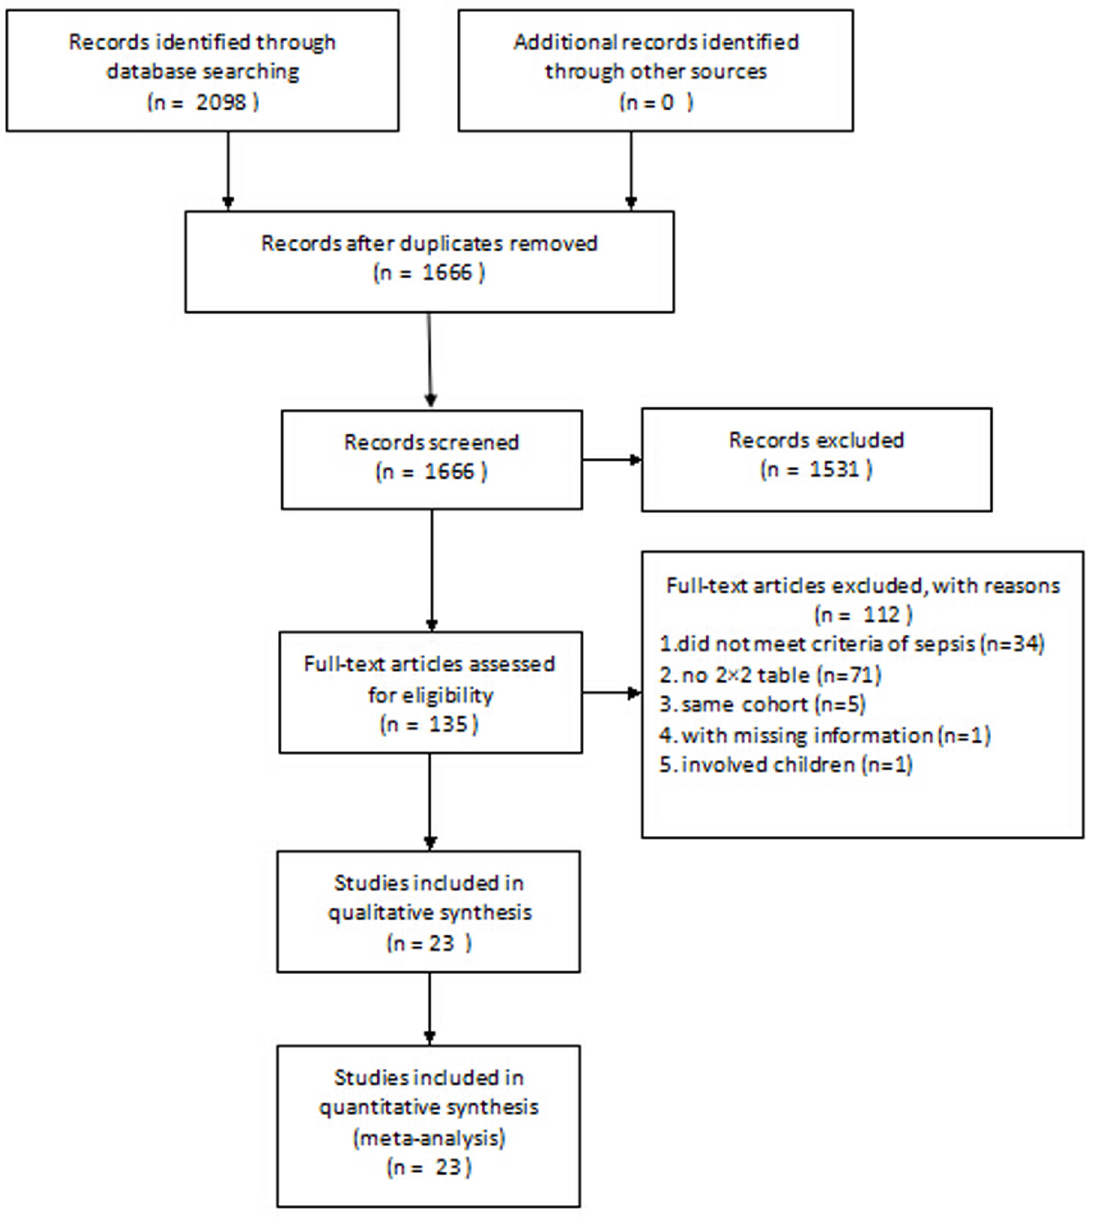
Fig 1. Flowchart of study